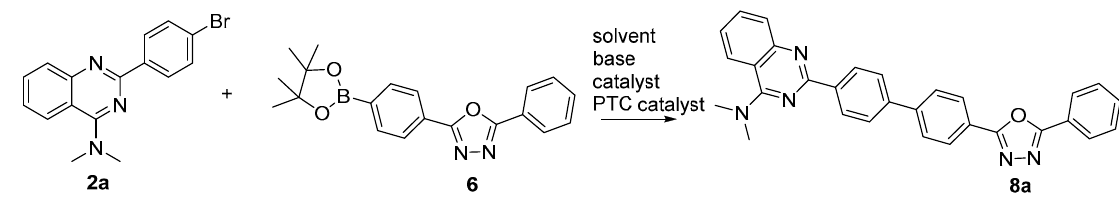
Table 1. Initial optimization for the cross-coupling reaction to obtain 8a